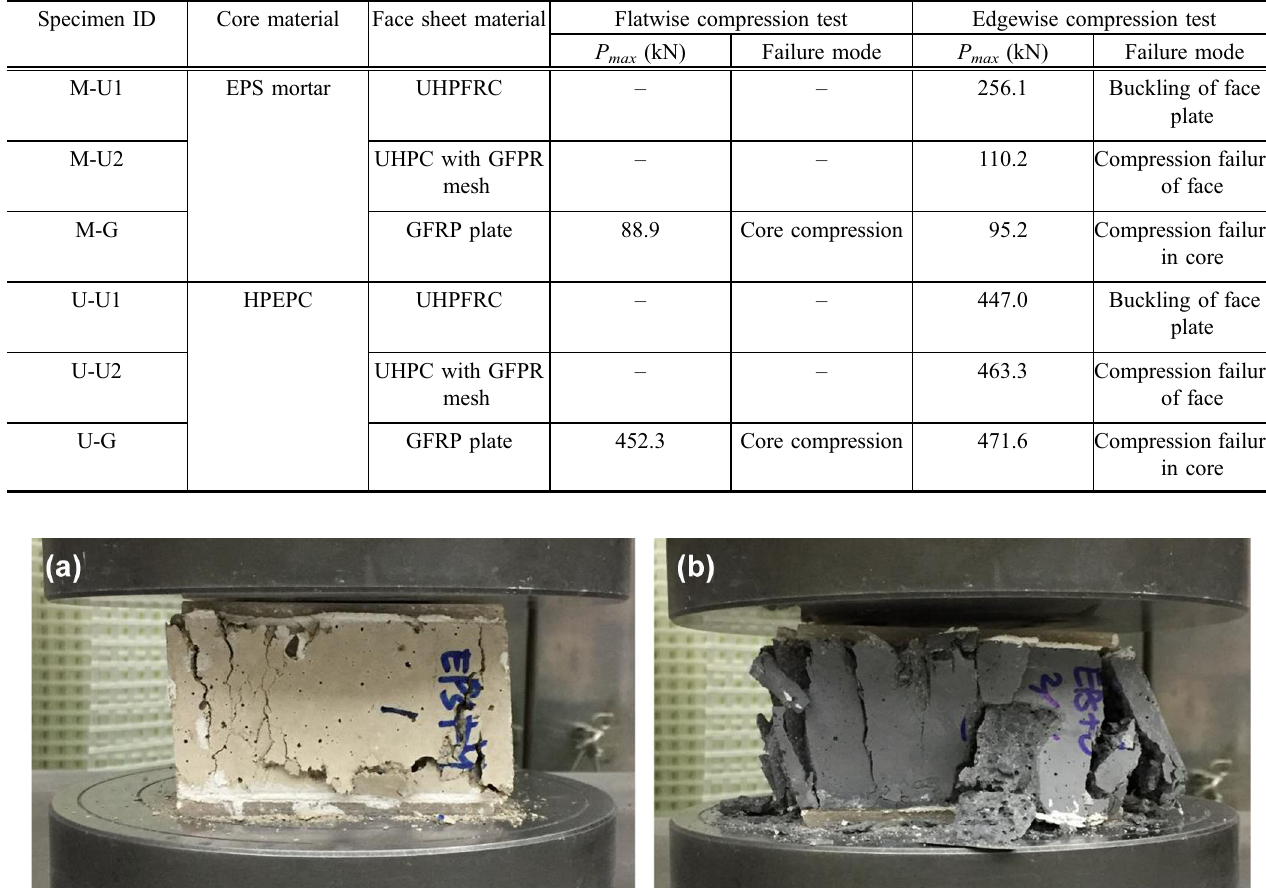
Table 7 Flatwise and edgewise compression test results for composite sandwich